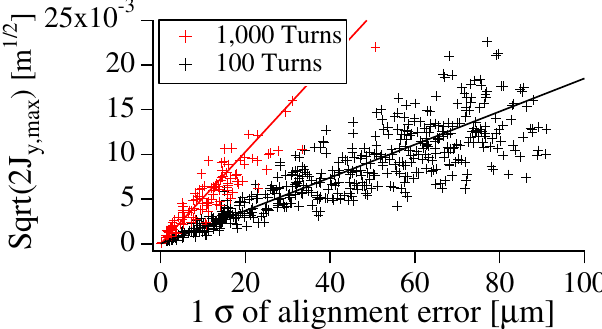
FIG. 3. (Color) Maximum amplitude through the whole cycle for two example acceleration rates of 100 and 1000 turns.